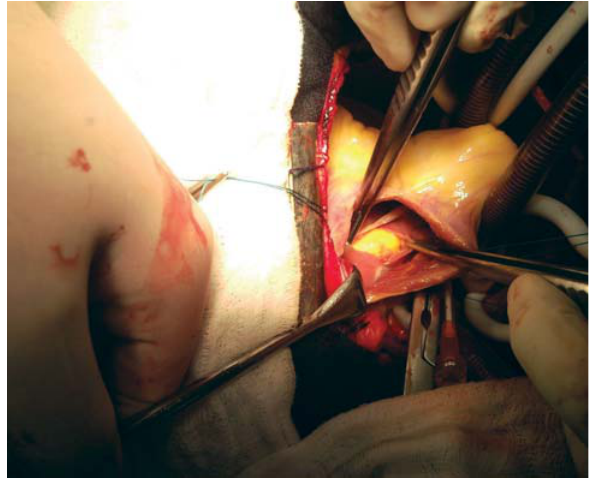
Fig. 1 - Aspecto cirúrgico demonstrando o ventrículo direito aberto e o lipoma sendo ressecado após incisão na musculatura do septo interventricular Fig. 2 - Lipoma